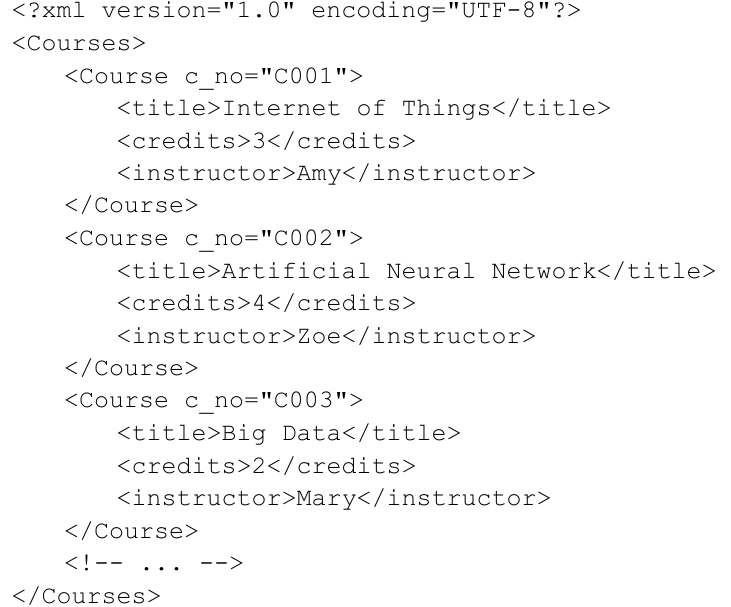
Table 4. An example of a data table in a multivalue database. Table Name: Students SID